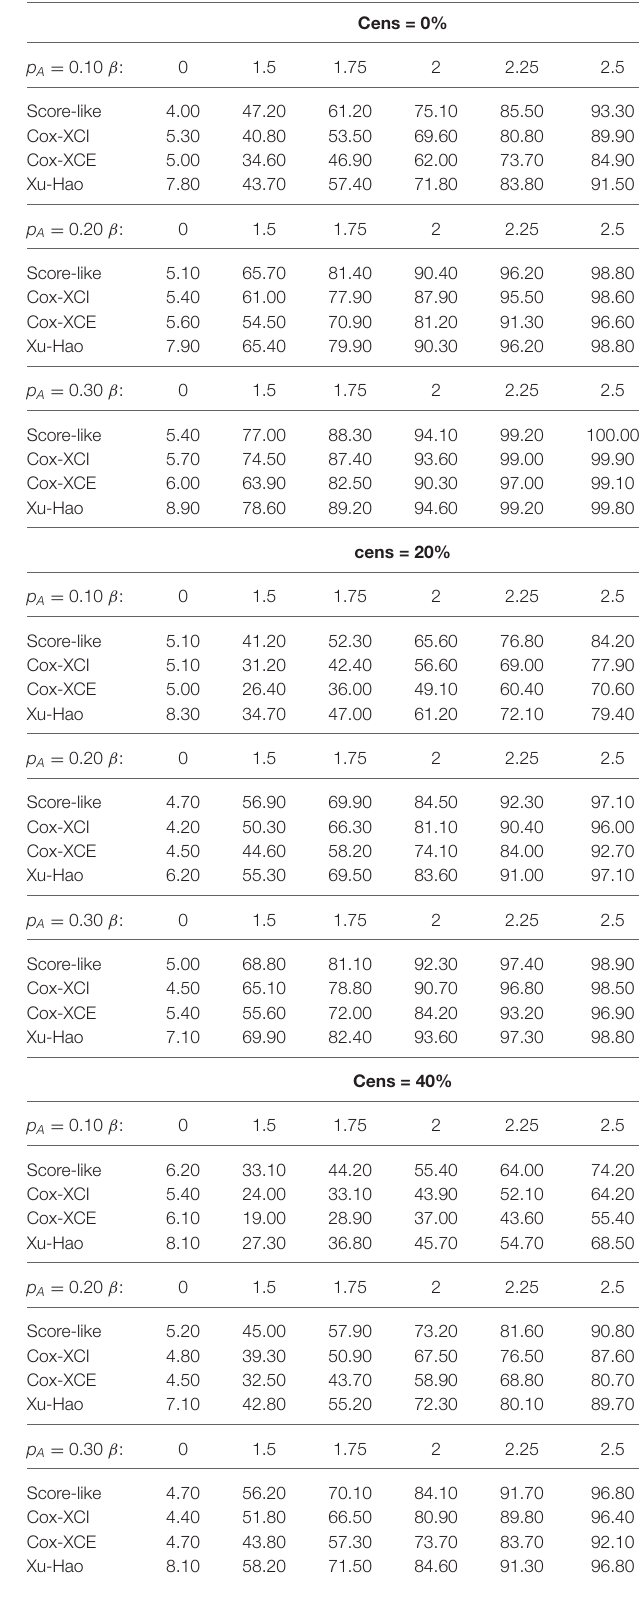
TABLE 2 | Size and power of tests (Score-like, Cox-XCI, Cox-XCE, Xu-Hao) for XCI-S with Beta distribution (threshold level of 0.05). Cens =